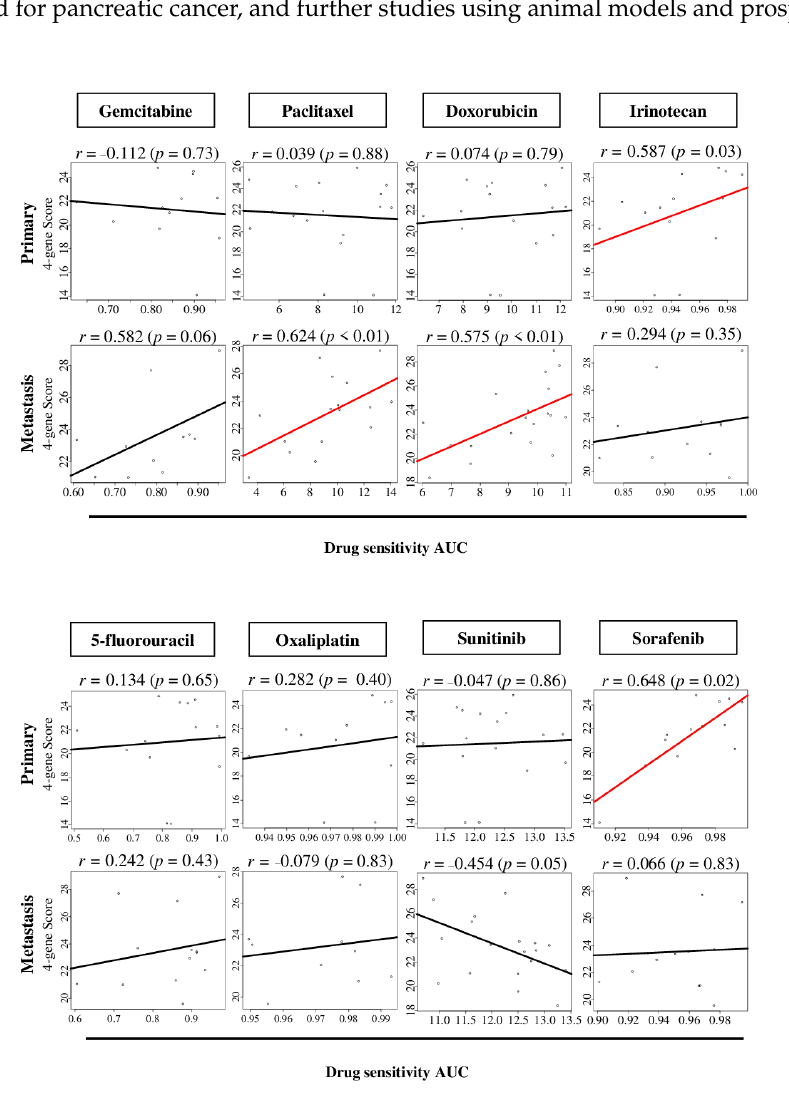
Figure 6. The correlation of the four-gene score with drug sensitivity of several drugs, from cell line data from the DepMap portal. The correlation plots are between the four-gene score and the level of drug sensitivity area under curve (AUC) of gemcitabine, paclitaxel, doxorubicin, irinotecan, 5-fluorouracil, oxaliplatin, sunitinib, and sorafenib in primary and metastatic pancreatic cancer cell lines. Spearman correlation statistics were used for the